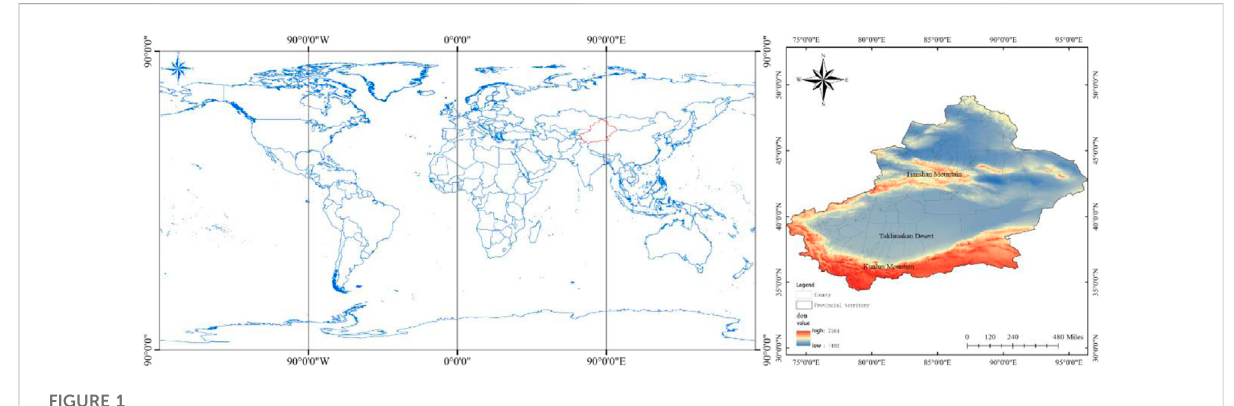
FIGURE 1 Geographical location of the study